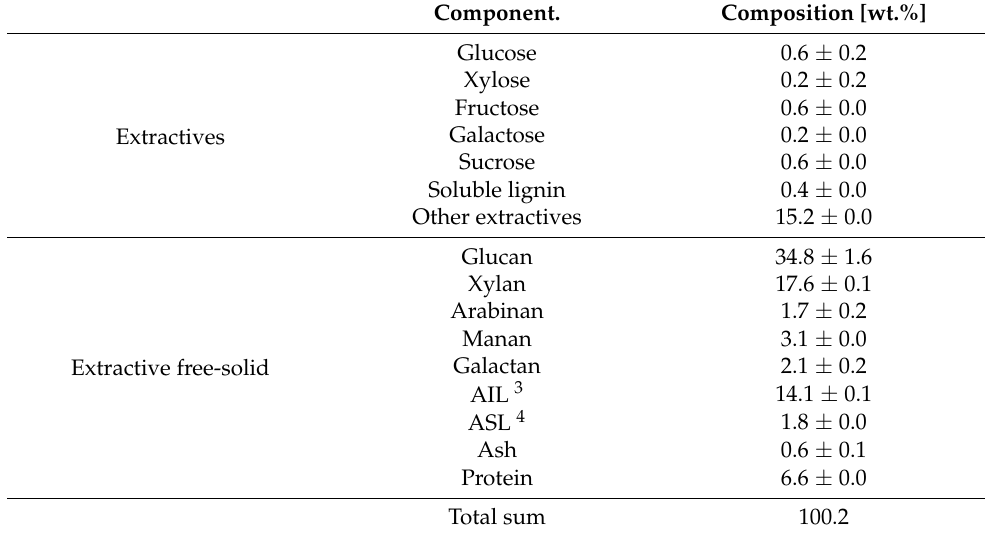
Table 1. Composition of corn stover 1,2 .